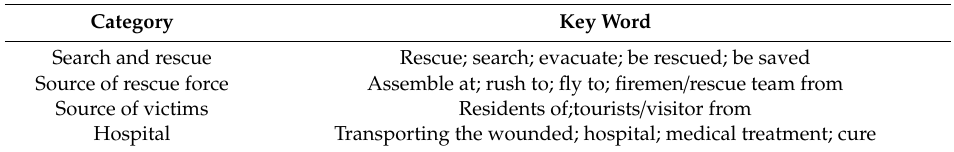
Table 4. Rescue microblog categories and keywords.